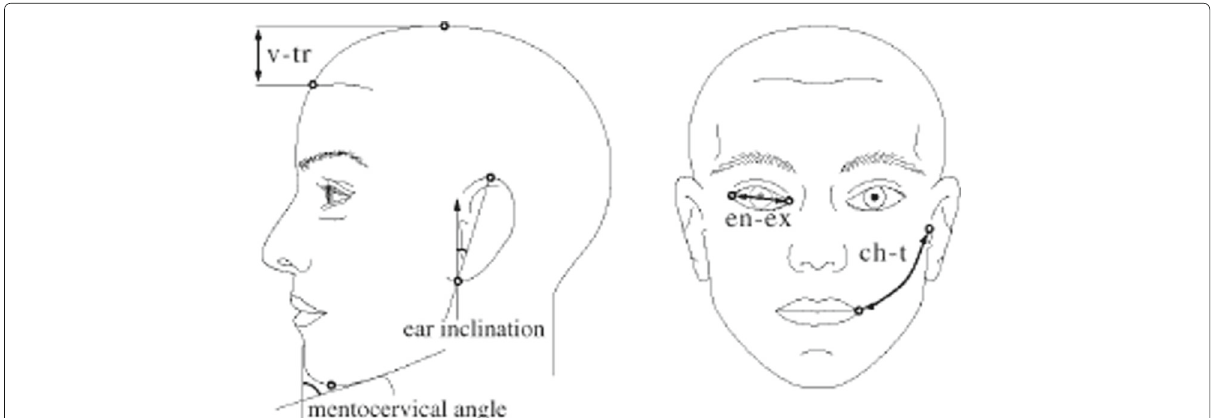
Fig. 2 Sample of anthropometric